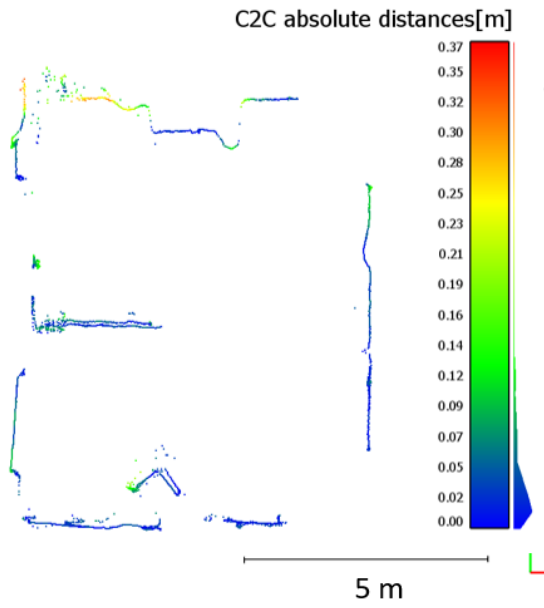
Figure 6 . Crazyflie point cloud map, coloured based on point distance to the MAX Grape map, in the Berrozi dataset.